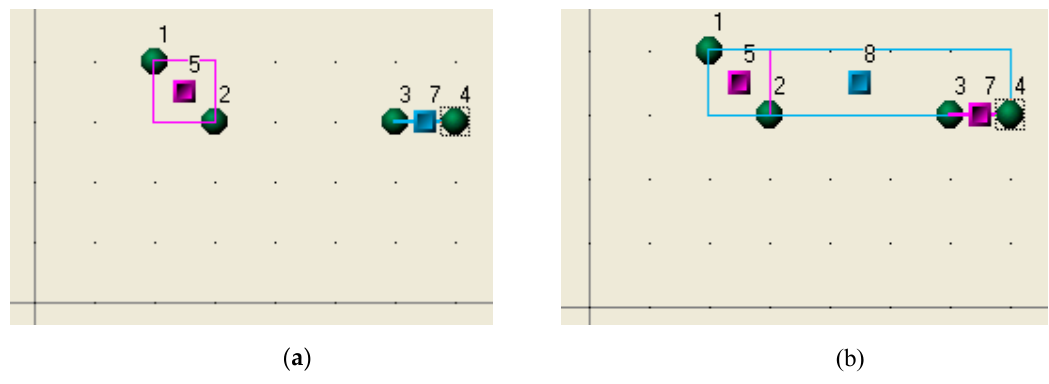
Figure 3. ( a ) Formation of Cluster 7; ( b ) Formation of Cluster 8